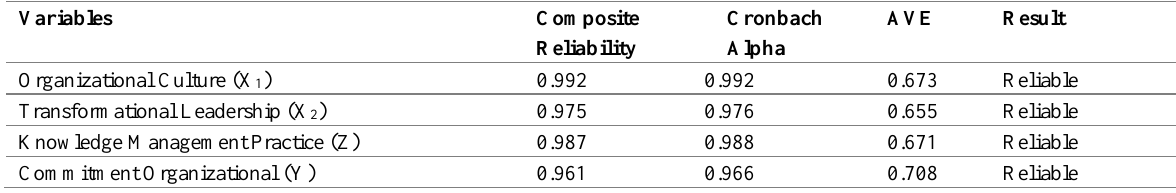
Table 1: Composite Reliability, Cronbach Alpha, AVE